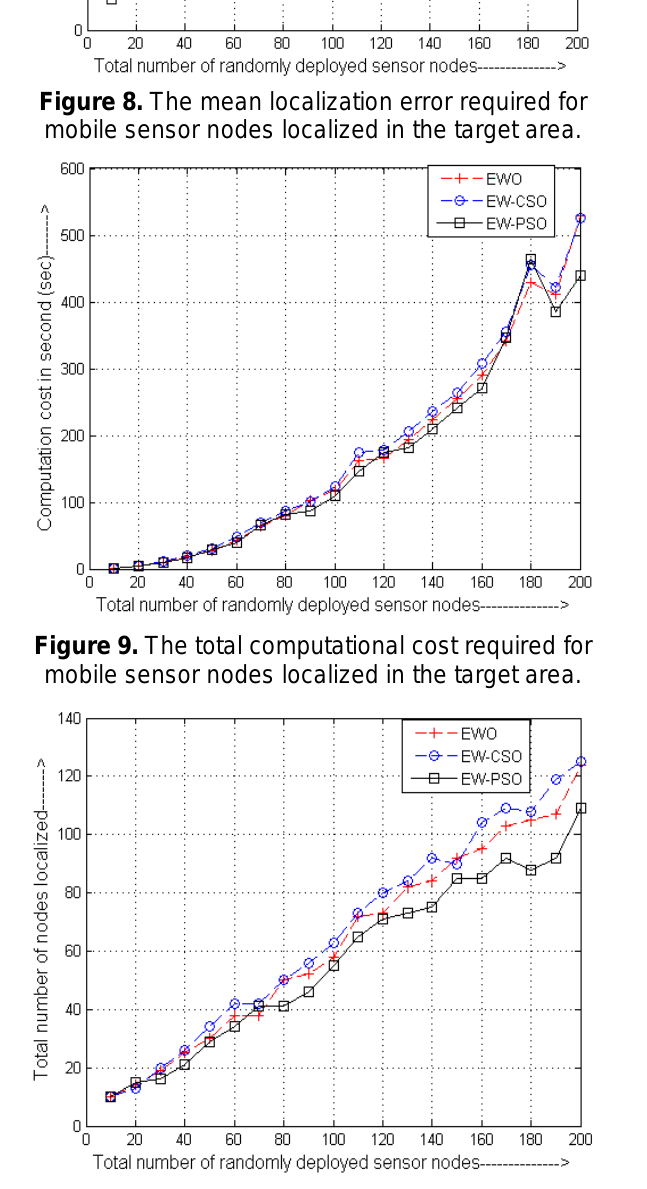
Figure 10. The total number of mobile sensor nodes localized in the target